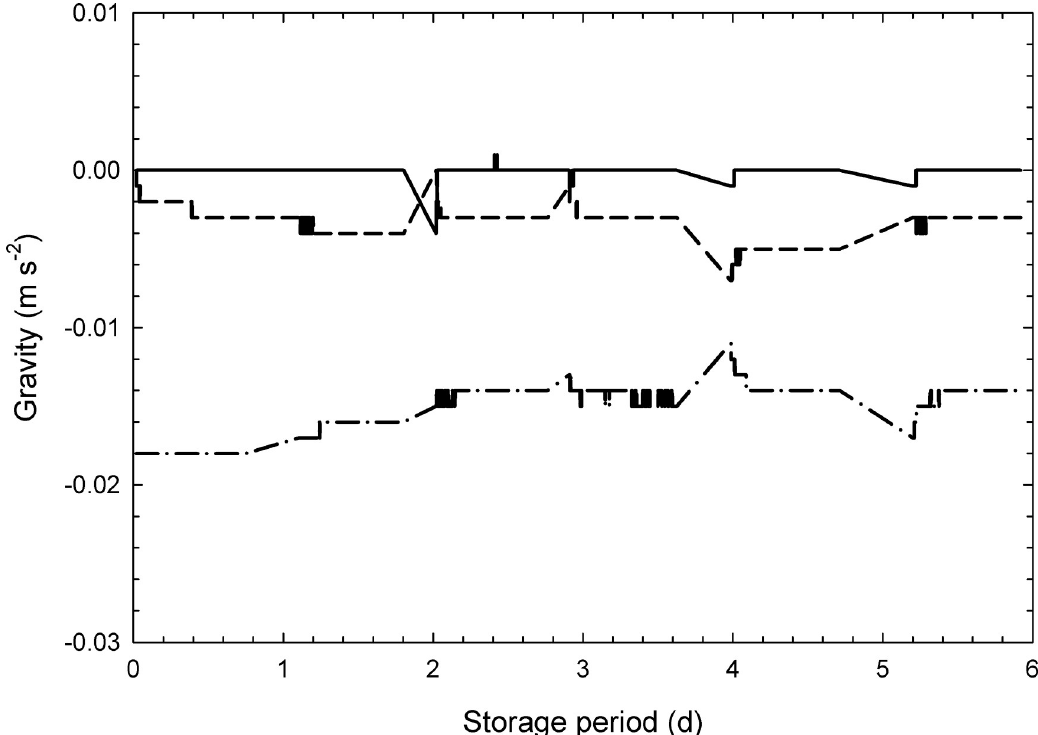
Fig 2. Changes in gravity on the gravity controller (e.g., mung bean sprouts). Full line: x axis, dashed line: y axis, chain line: z axis.